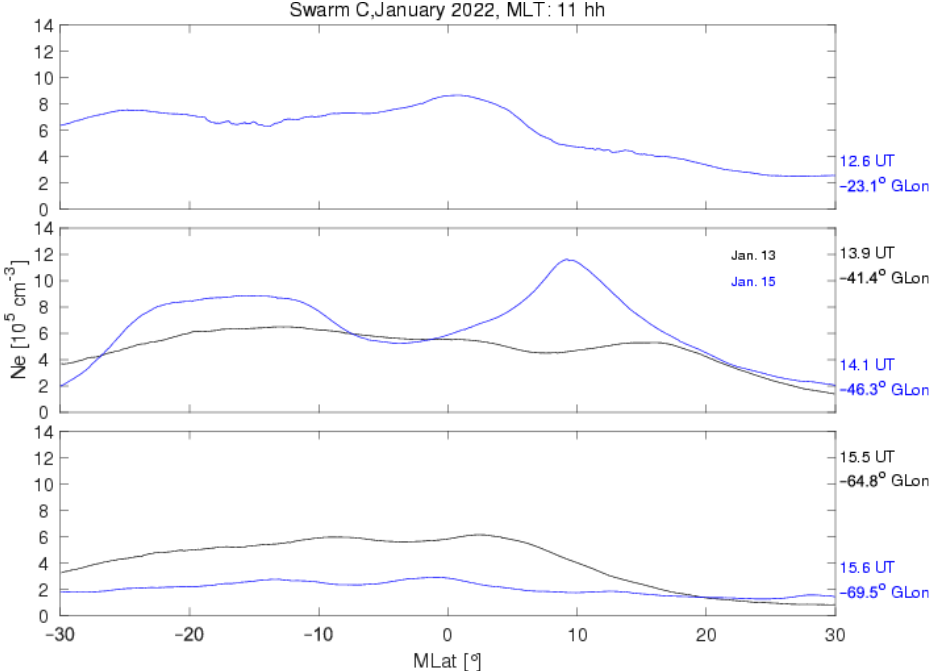
Figure 4. The magnetic latitudinal variation of ionospheric F region electron density in the daytime (11 MLT) observed by Swarm C between 12:00 UT and 16:00 UT on 15 January 2022 (blue curve). For comparison, Ne between 13:00 UT and 16:00 UT on 13 January 2022 are also shown in black curve. The UT and GLon of the satellite passing through the magnetic equator are listed on the right axis.